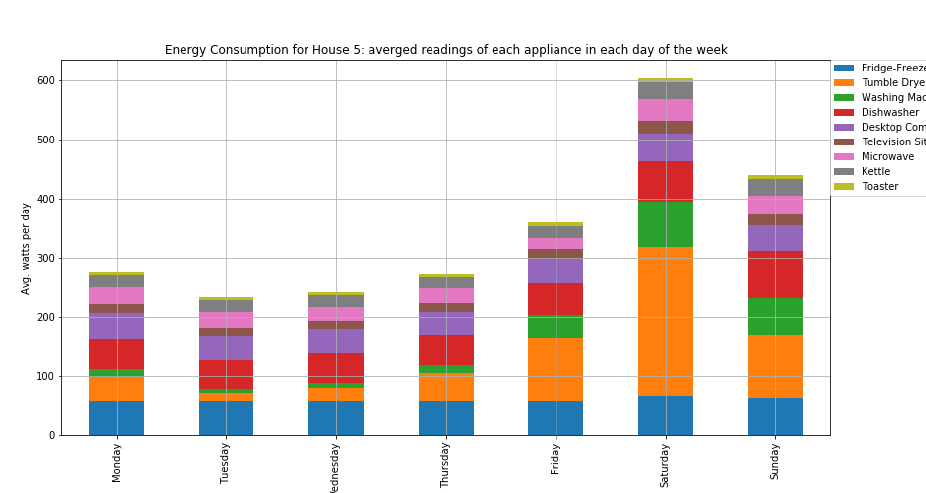
Figure A5. The average consumption per month of home appliances for house 5 with four occupants.